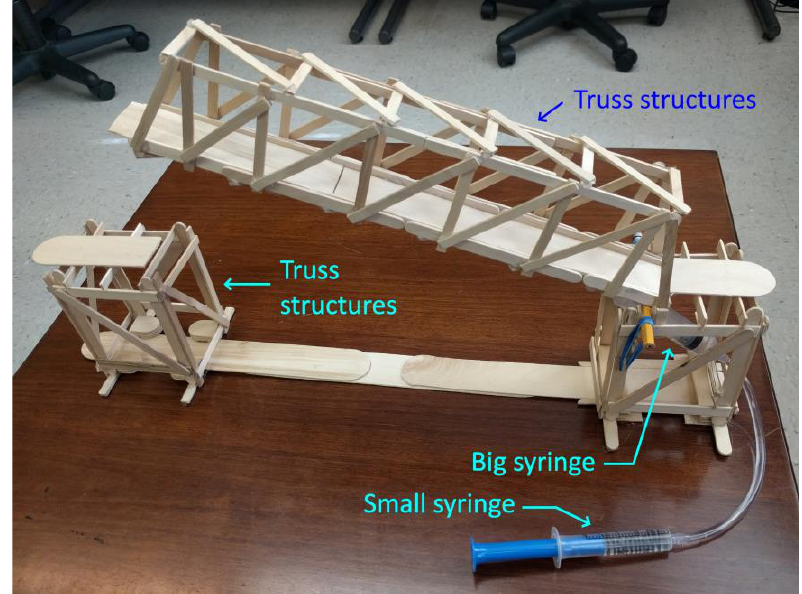
Fig. 2. An example of a movable popsicle hydraulic bridge as a civil engineering